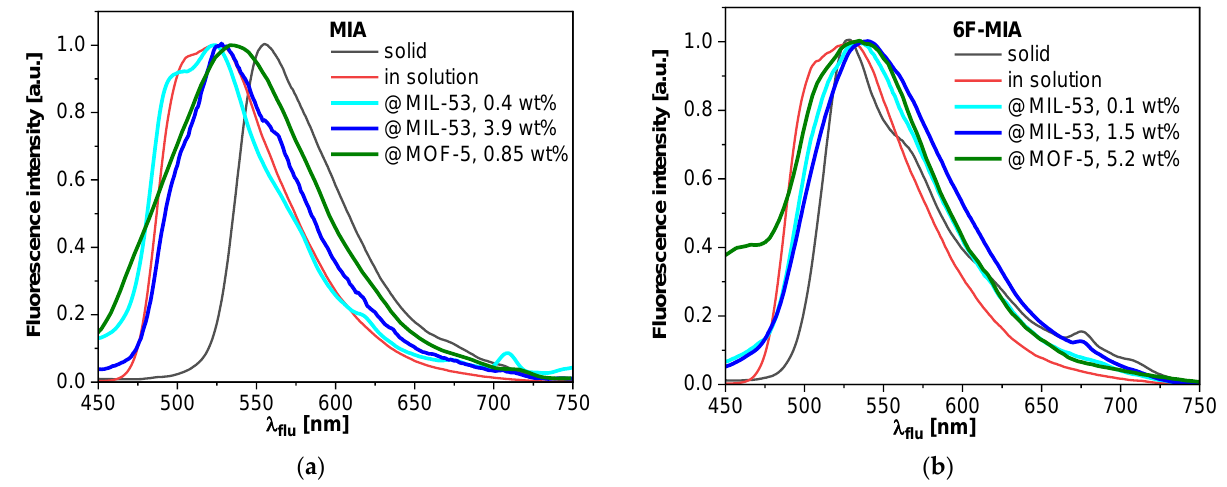
Figure 5. Normalized fluorescence spectra at room temperature of ( a ) MIA and ( b ) 6F-MIA in their neat solid state, in 1:1 DCM/MeOH solution and for the flavin@MOF composites; wt% refers to the flavin loading. Since the fluorescence signal of flavin@MOF composites with low loading is weak, the contributions of scattered excitation light at short emission wavelengths becomes relevant, which causes additional shoulders in the spectra at short wavelengths.